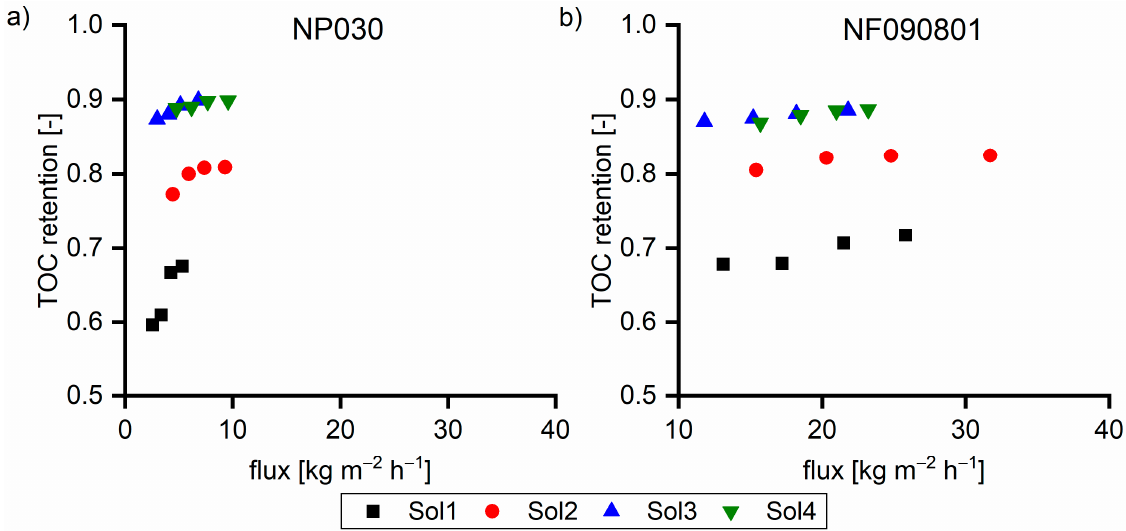
Figure 8. TOC retention of ( a ) NP030 and ( b ) NF090801 with various feed solutions at 40 °C. The applied pressure values were 35, 30, 25, and 20 bar, respectively.